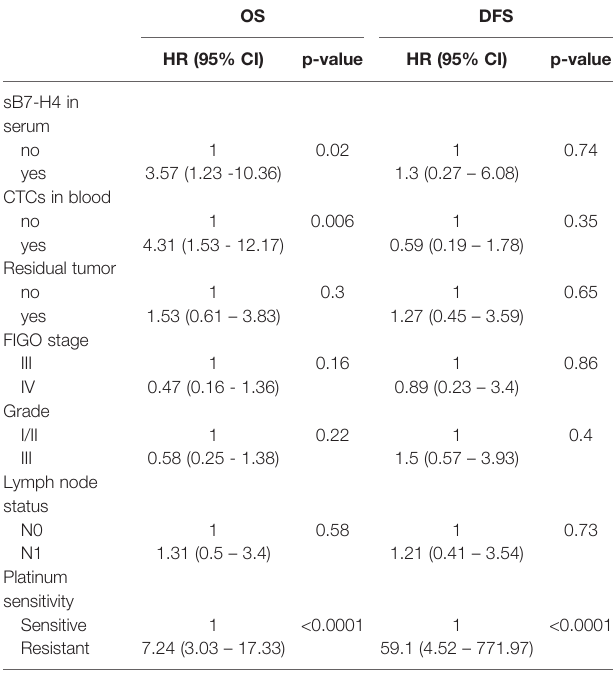
TABLE 4 | Effect of sB7-H4 and CTCs presence on OS and DFS after correcting for unfavorable prognostic factors in cox proportional hazards regression model.